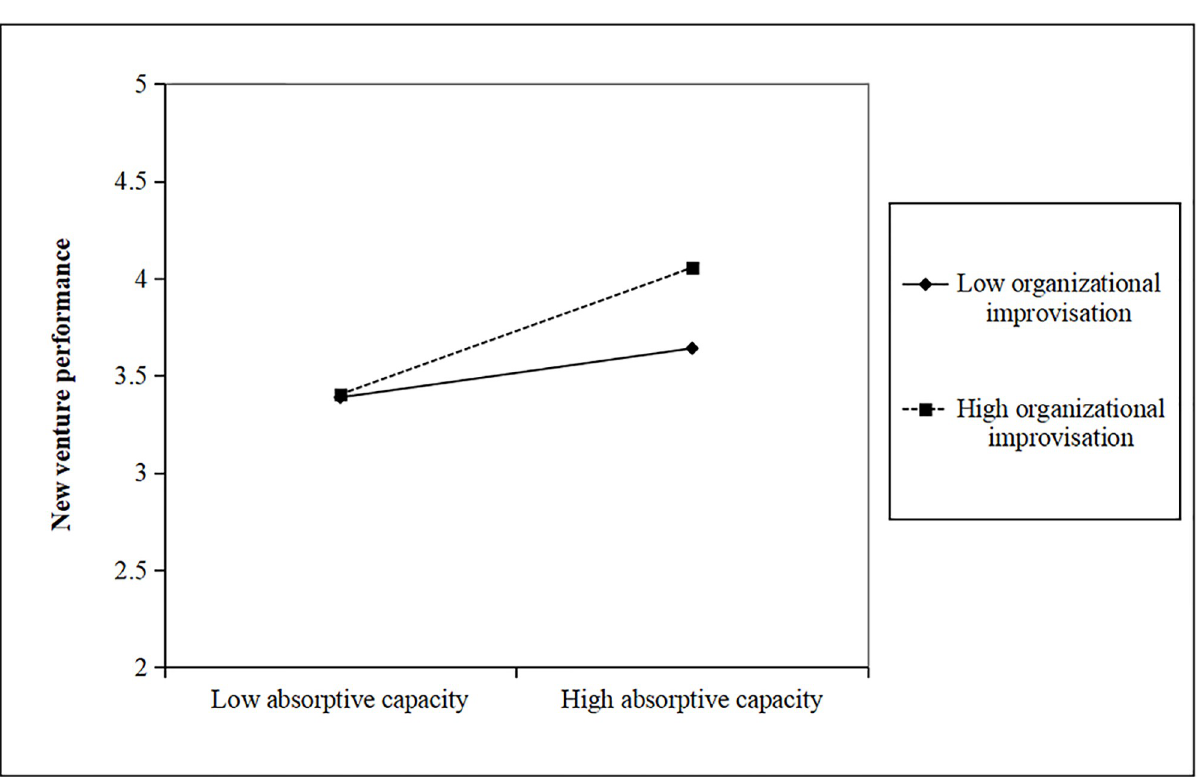
Fig 3. The moderating effect of organizational improvisation.